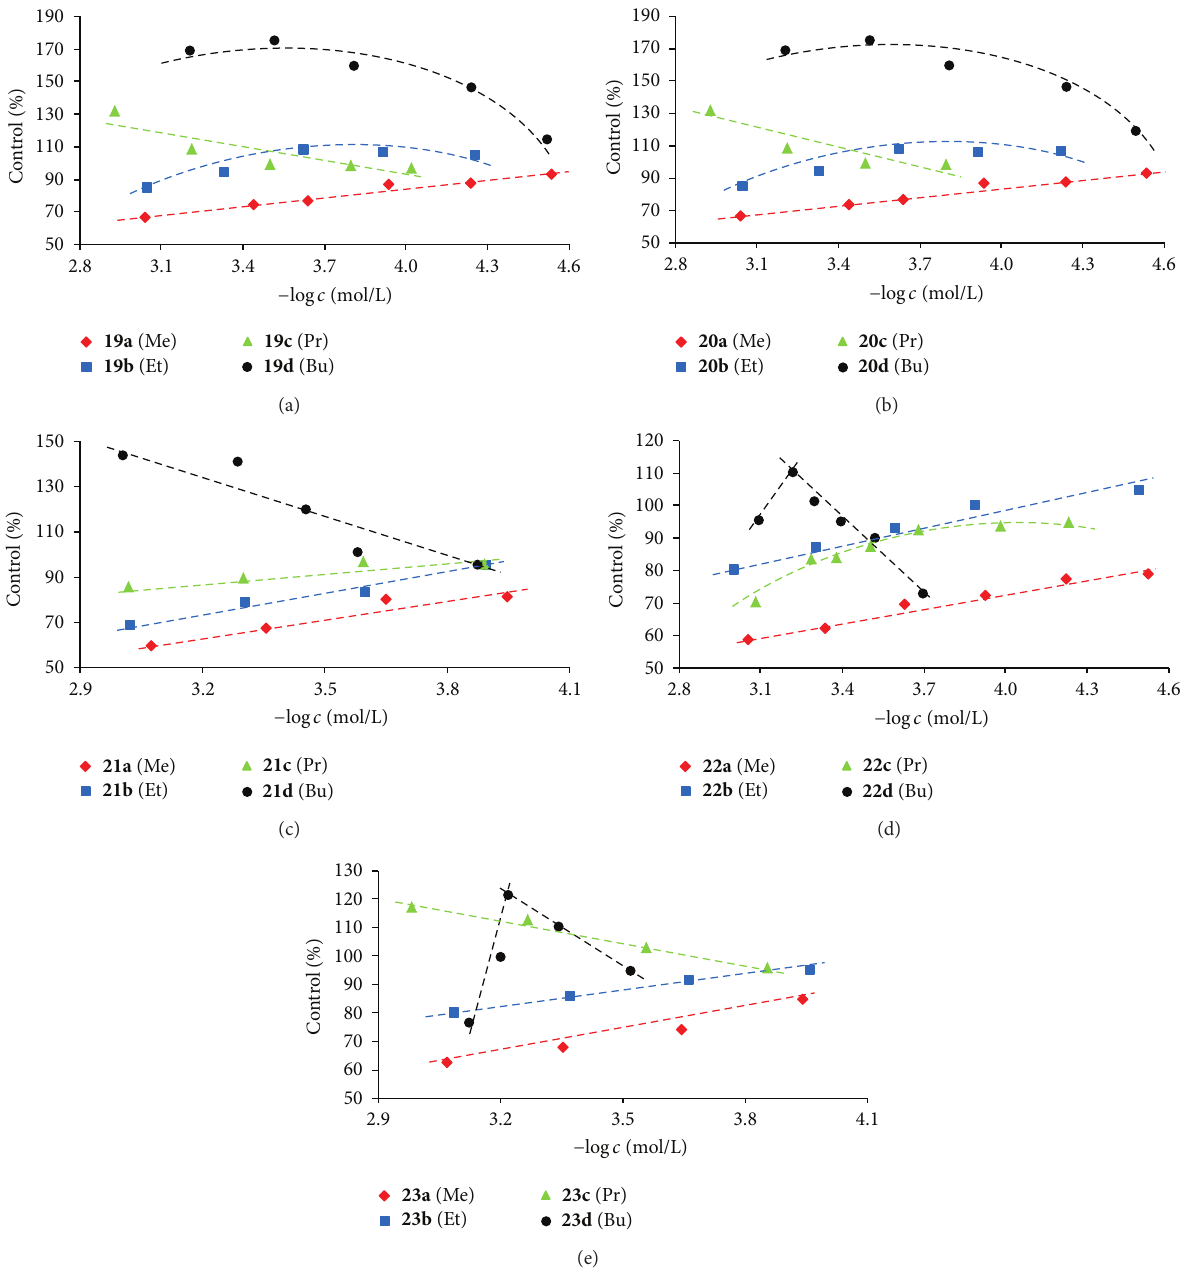
Figure 2: Dependence of the rate of photosynthetic electron transport (expressed in % of the control) on the negative logarithm of compound concentration: 19a – d (a); 20a – d (b); 21a – d (c); 22a – d (d); 23a–d